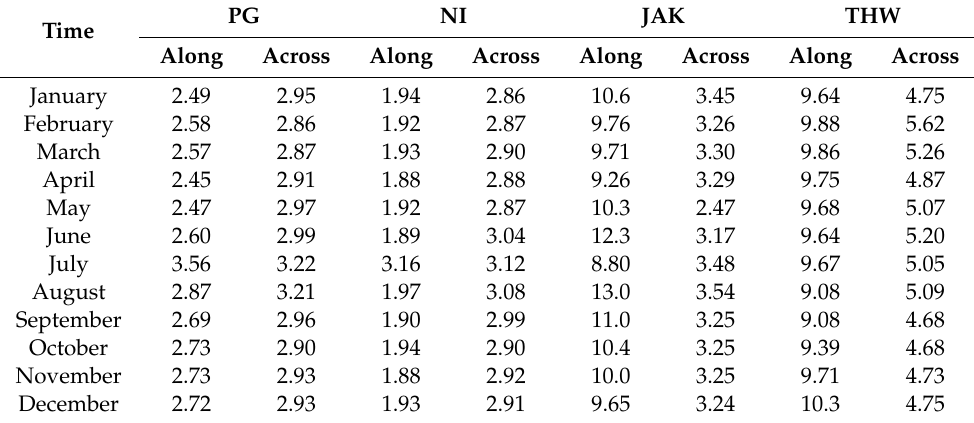
Table 2. Monthly average flow velocities for the four considered glaciers extracted from the reference literature [47]. Values are expressed in m / day. PG NI JAK THW Time Along Across Along Across Along Across Along